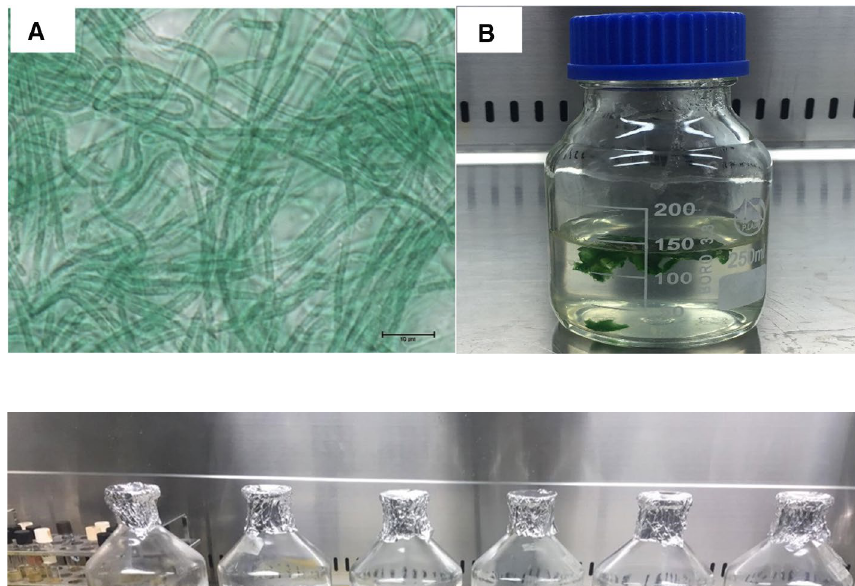
Fig. 1 a Morphological image of Pseudanabaena galeata strain isolated from freshwater. b Pseudanabaena galeata culture in BG13 medium